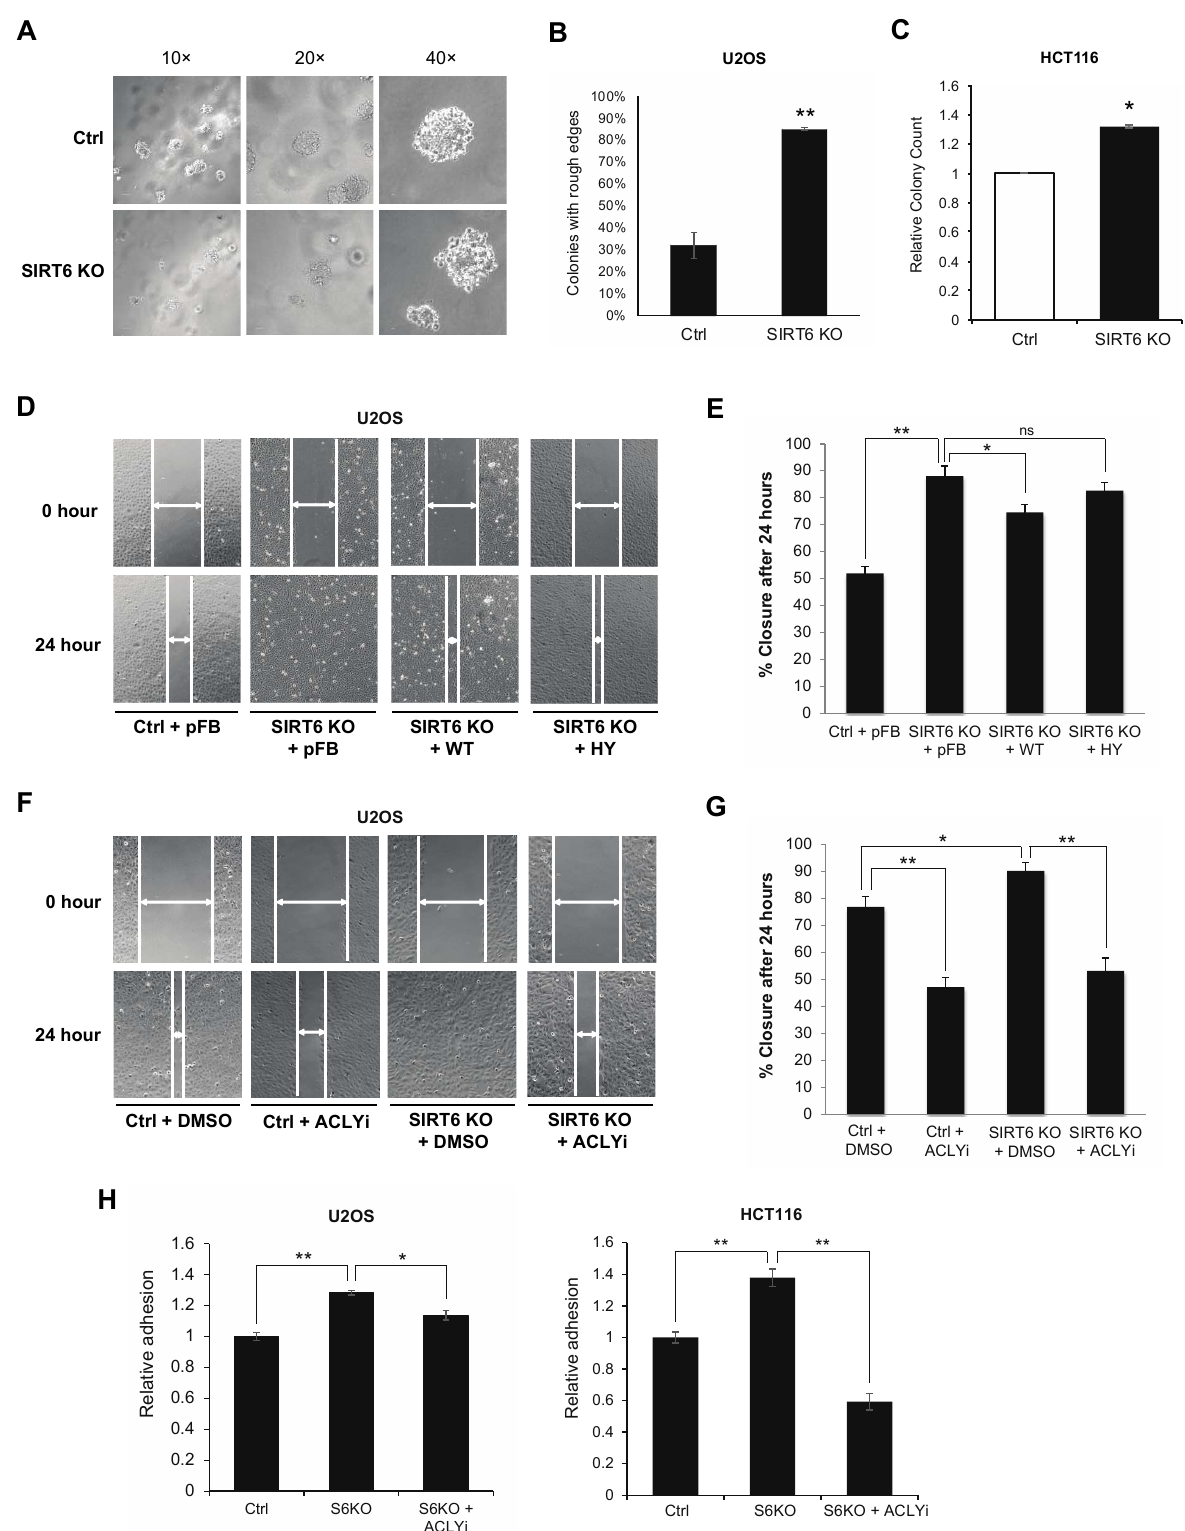
Figure 3. Adhesion and migration phenotypes of SIRT6-deficient cells and cells with ACLY inhibition. ( A ). Morphology of colonies formed by control or SIRT6 KO U2OS cells in soft agar colony formation assay. ( B ). Quantification of colonies with rough edge morphology. Colony counts were obtained from 10 random fields per well, four wells per cell type, n = 250, ** p < 0.01, two-tailed Student’s t -test. ( C ). Soft agar colony formation of control and SIRT6 KO HCT116 cells. Colony counts were obtained from three wells per cell type, * p < 0.05, two-tailed Student’s t-test. ( D ). Representative images of wound healing scratch assay in control and SIRT6 KO U2OS cells stably expressing empty vector (pFB), wild-